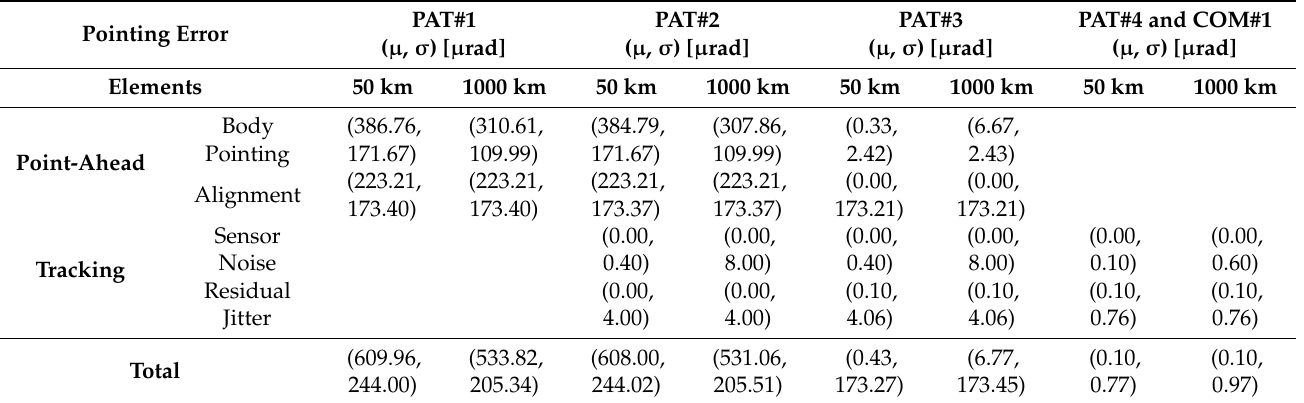
Table 3. Pointing errors elements and values for each PAT sequence.